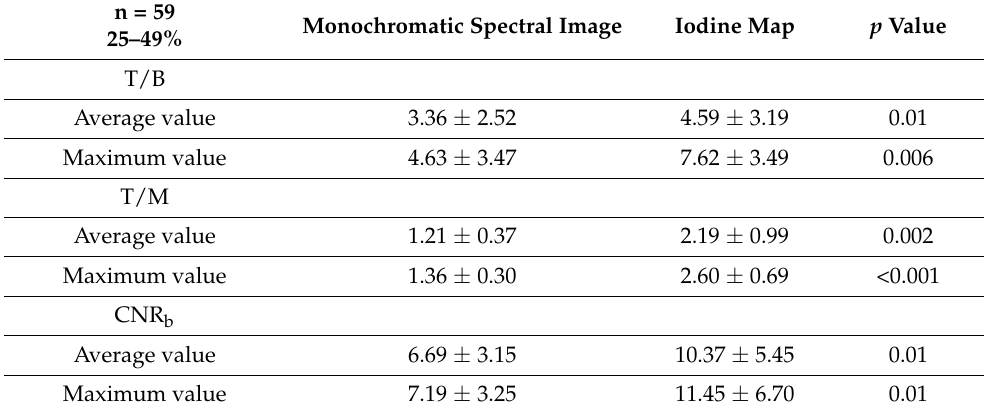
Table 4. Comparison of T/B, T/M, and CNR b obtained from the monochromatic spectral images and iodine maps for breast density of 25–49%.